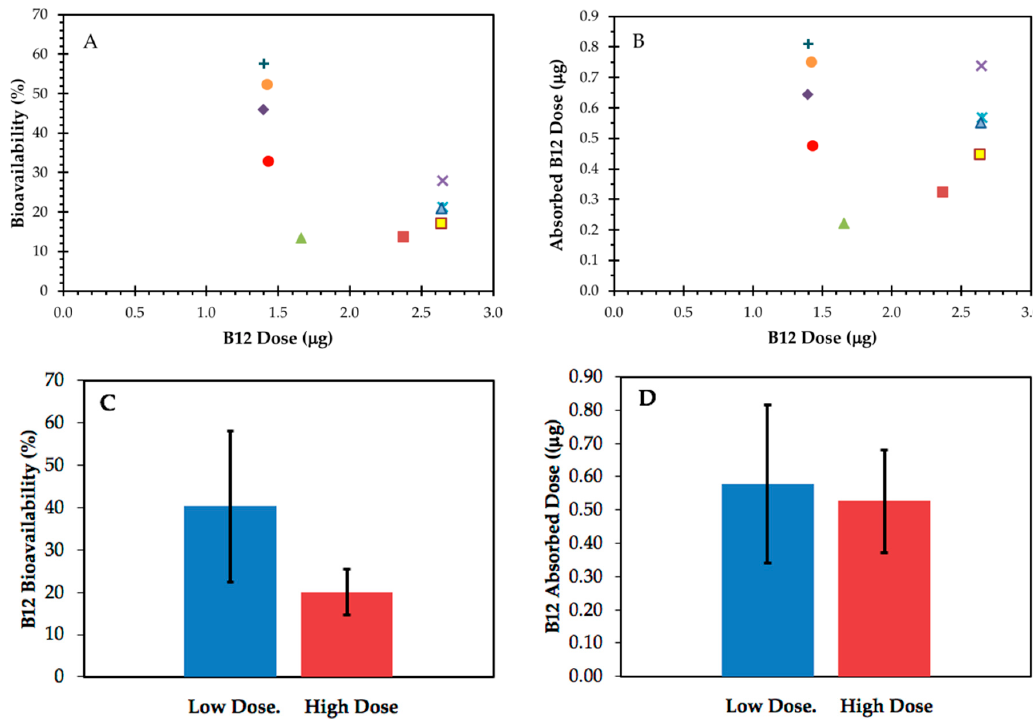
Figure 7. Relationship between bioavailability and total dose of B12. ( A ) Percent bioavailability values for subjects S1–S10. ( B ) The relationship between absorbed dose and total dose of B12. The symbols for the subjects follow the convention of earlier figures. ( C ) Mean % bioavailability values in subjects receiving lower doses of total B12 in the eggs (1.43–1.66 μ g, n = 5) and in those receiving higher doses of total B12 in the eggs (2.38–2.65 μ g; n = 5) were compared with Student’s t-test ( p =